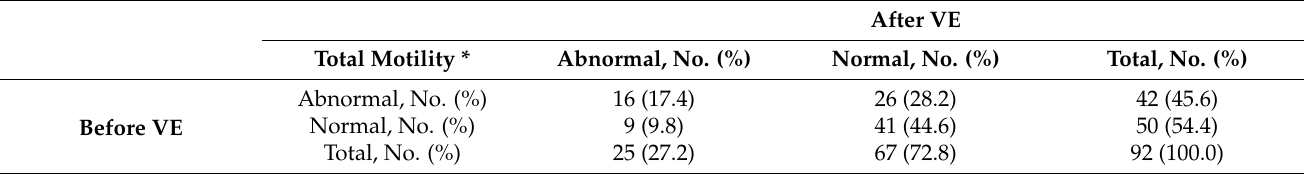
Table 6. Cross-tabulation table showing the number of patients with abnormal and normal total sperm motility at 1 h (H1) in the first semen analysis before varicocele embolization (VE) versus in the second semen analysis after VE.